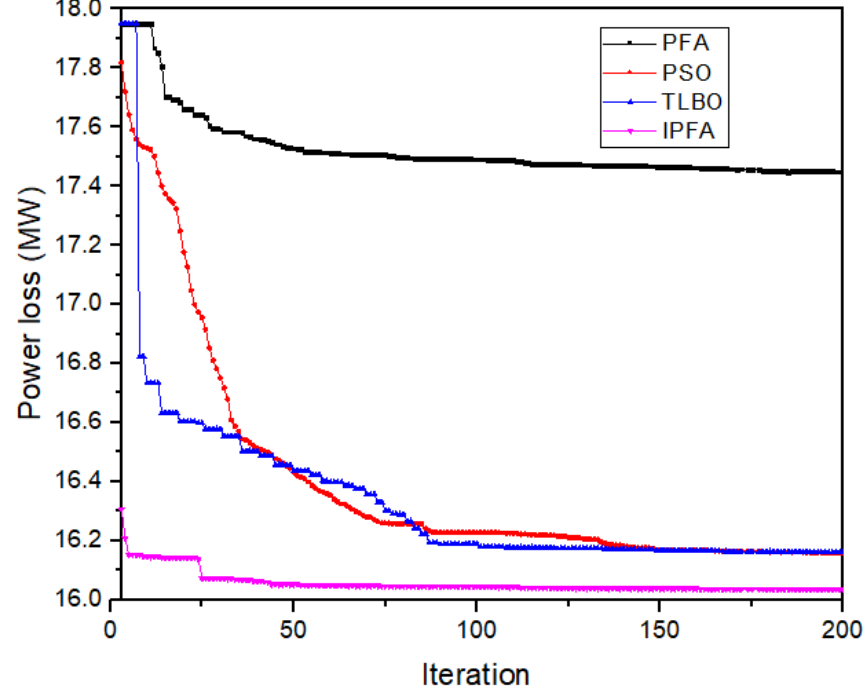
Figure 3. Convergence curve of the IEEE 30 bus system for diminished power loss .